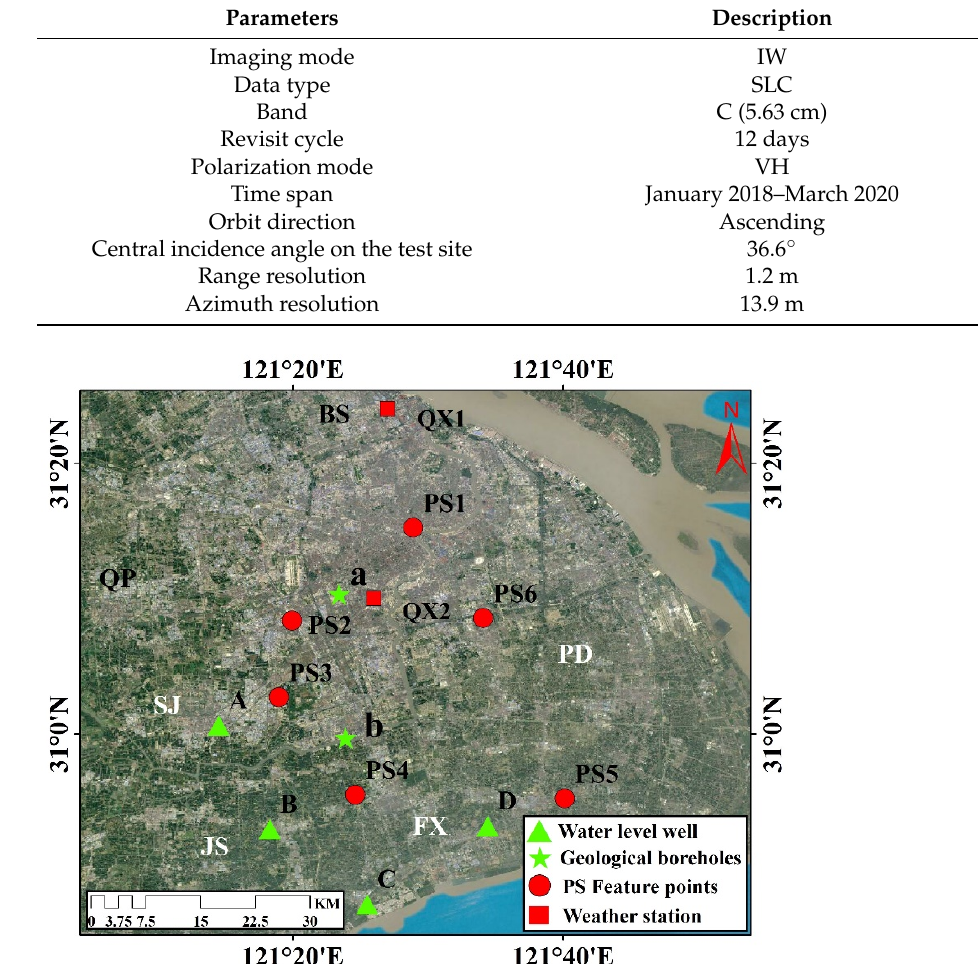
Figure 3. Distribution of data points. The green triangles depict the water level of wells, green pentagrams denote the geological boreholes, red circles represent the PS feature points, and the red squares denote the weather stations.